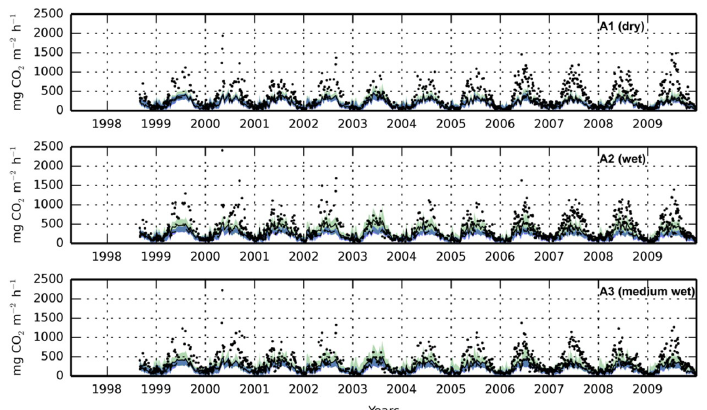
Figure 6. Measured data (black dots) and simulated confidence intervals for the CO 2 emissions for the plots A1, A2 and A3 (from top). Confidence intervals for noGW simulations are shaded in light blue, withGW simulations are in light green and overlap between noGW and withGW in darker blue-green. Black lines depict the median for withGW (solid line) and noGW (dashed line) simulations. Additional information can be found in Table A3 and A4.